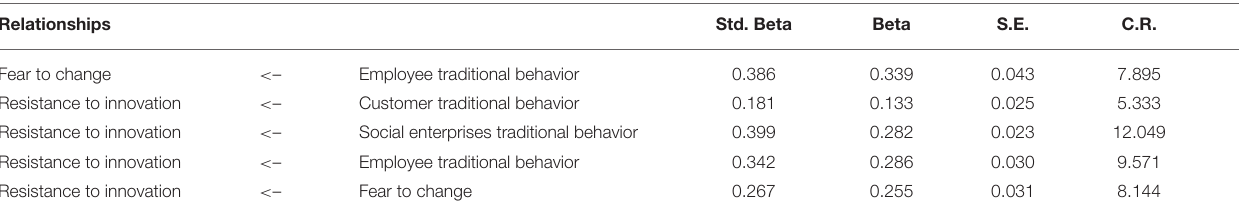
TABLE 6 | Direct path analyses.